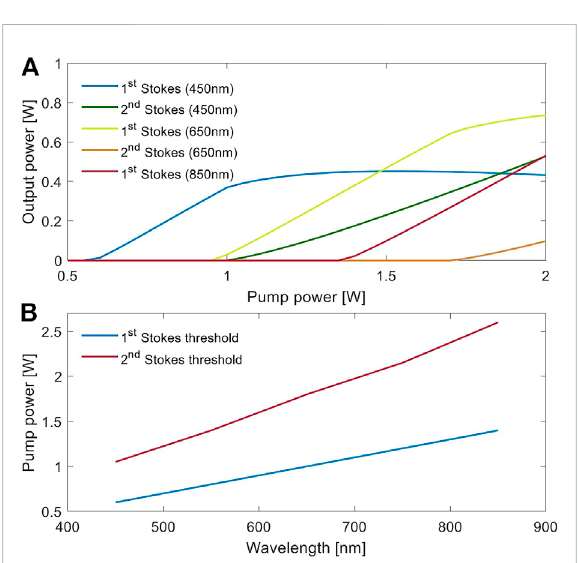
FIGURE 4 (A) Simulation results of Stokes output power for